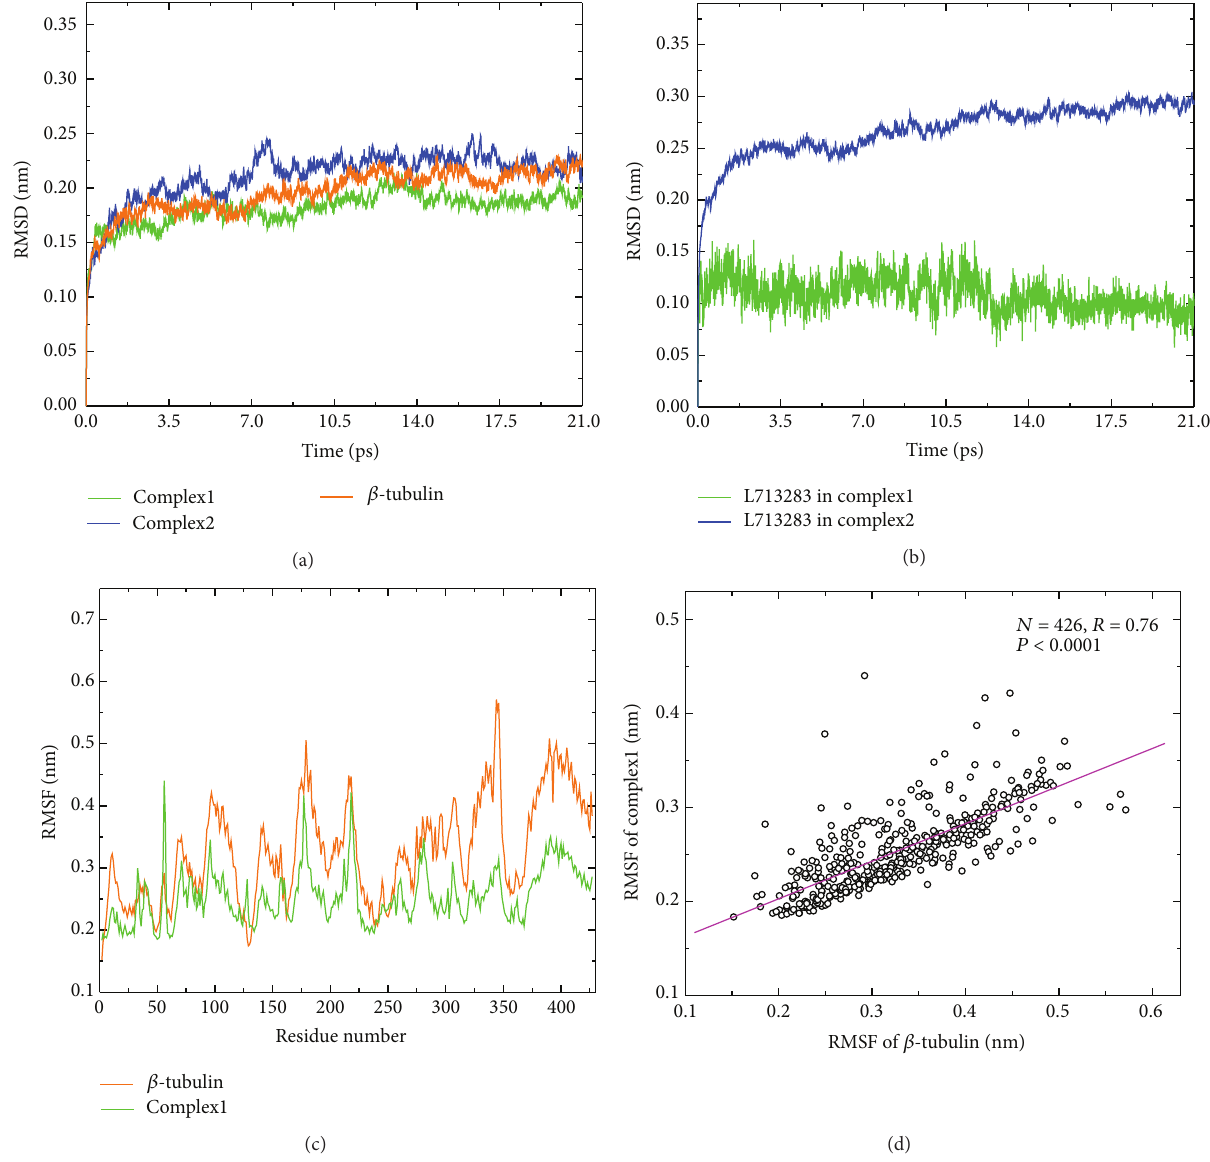
Figure 5: Comparative RMSD and RMSF analysis of complex1, complex2, and 𝛽 -tubulin systems. (a) The RMSD values of backbone C 𝛼 atoms versus simulation time. (b) The RMSD values of L713283 versus simulation time in complex1 and complex2 systems. (c) The RMSF values of C 𝛼 atoms in complex1 and 𝛽 -tubulin systems. (d) The correlation of RMSF between complex1 and 𝛽 -tubulin systems.